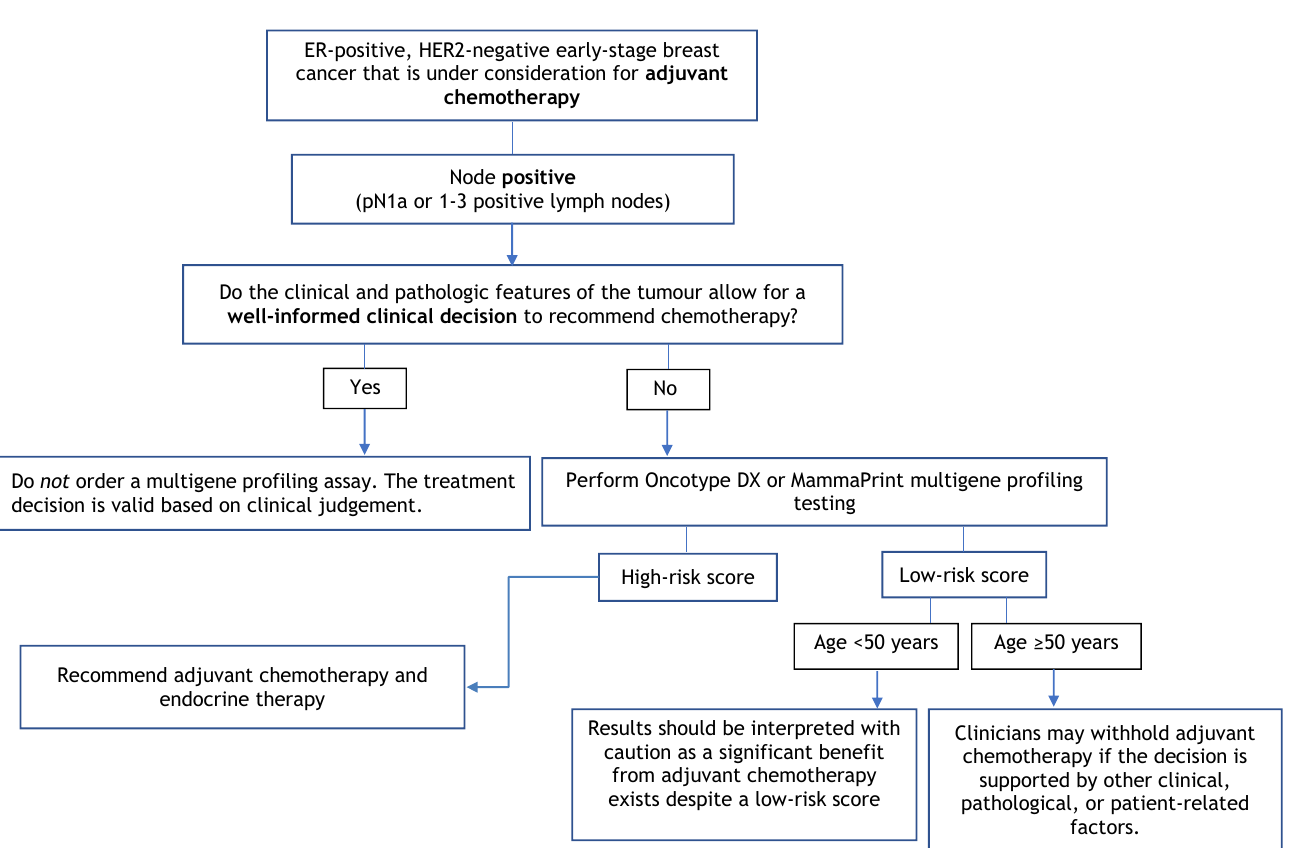
Figure 2. Multigene Profiling Assay Decision Tree for Adjuvant Chemotherapy in Node-Positive Patients.